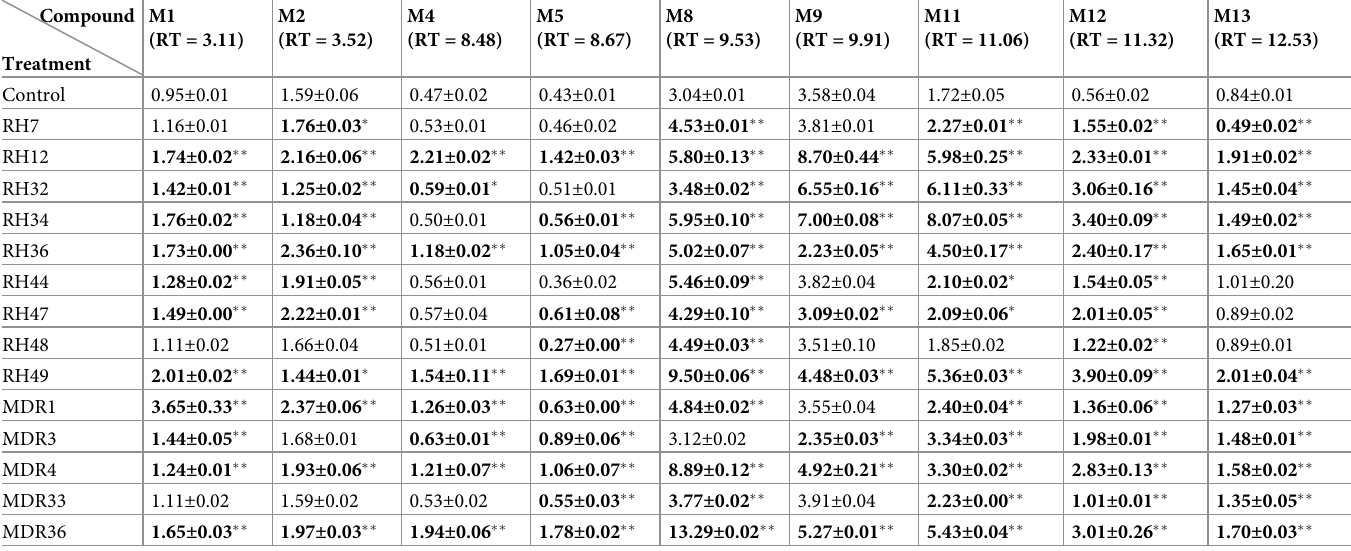
(Tables 3 and 4). Nine metabolites were codetected in all CS and RH leaf samples, and 8 of these metabolites were codetected in both varieties. Metabolite M15 was only detected in CS leaves, and metabolite M5 was only detected in RH leaves. The concentrations of these metab- olites and the different significances between treatments are presented in Tables 3 and 4. The concentration of these metabolites in grape leaves were differentially influenced by the symbio- sis of diverse fungal strains, and some of these changes reached statistical significance (Tables 3 and 4). For CS grape leaves, RH34, RH36 and MDR1 significantly promoted the contents of Table 4. Content of co-detected metabolites in RH grape leaves and the different significances. Compound